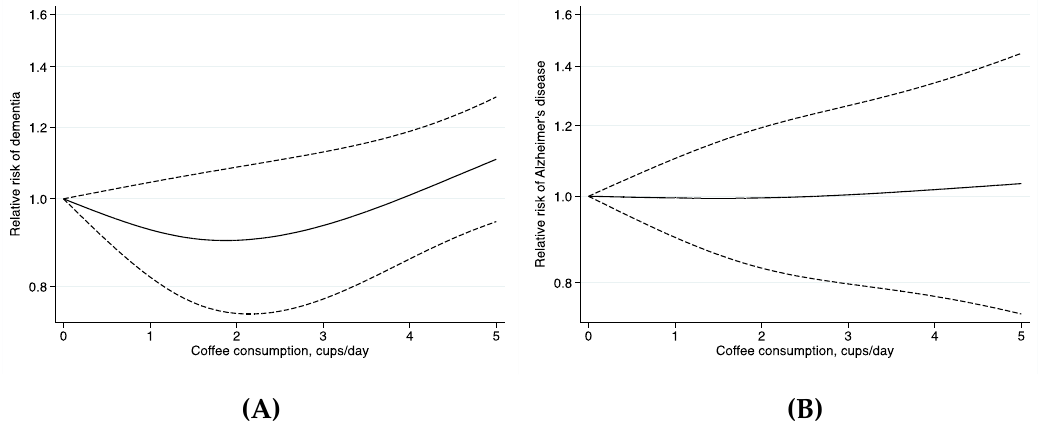
Figure 2. Dose-response association of coffee consumption with risk of dementia ( A ) and Alzheimer’s disease ( B ). The analyses of dementia and Alzheimer’s disease include eight and five prospective studies, respectively.